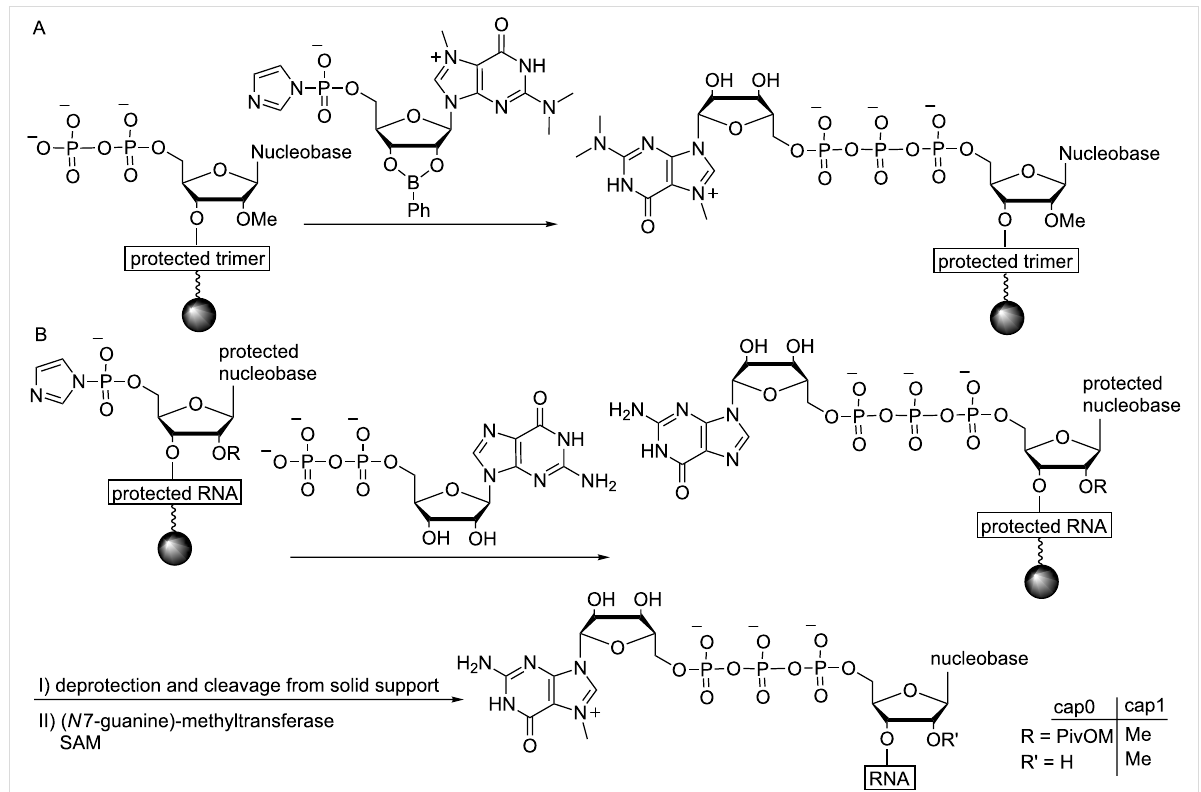
Figure 6: Synthesis of cap-containing RNA by solid-phase synthesis. (A) A TMG-capped mRNA was synthesized starting from an RNA tetramer which was subjected to 5 ′ -terminal pyrophosphorylation followed by reaction with a 2,2,7-trimethylguanosine 5 ′ -phosphorimidazolide derivative [112]. Subsequent cleavage from the solid support was achieved using 80% AcOH (rt, 24 h) and TBDMS protecting groups were removed with HCl (pH 2, rt, 12 h). (B) Large-scale production of RNAs with cap0 or cap1 by a combination of solid-phase synthesis and enzymatic methylation [111]. Deprotec- tion conditions: DBU (1,8-diazadicyclo[5,4,0]undec-7-ene) in acetonitrile (rt, 3 min) followed by treatment with aqueous ammonia (rt, 3